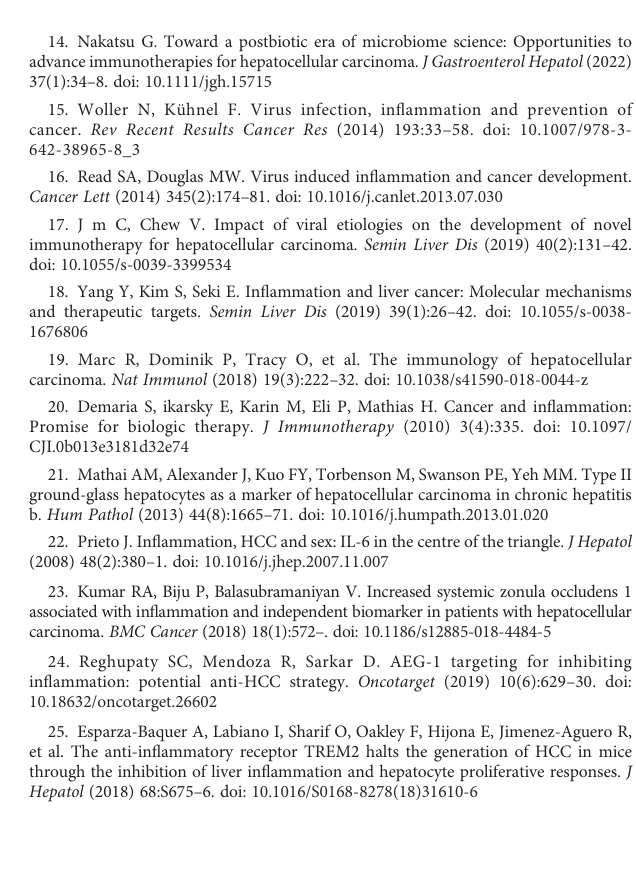
SUPPLEMENTARY FIGURE 1 Validation of prognostic models for six in fl ammation-related signatures. (A – C) risk score distribution, survival status, the expression level of hub genes, Principal component analysis, and Kaplan-Meier curves at different risk groups from ICGA database (A) and GSE84337 database (B) . *p < 0.05. SUPPLEMENTARY FIGURE 2 The correlation analysis of IRG and clinicopathological variables and corresponding strati fi cation analysis in virus-related HCCs. The correlation between IRG and (A) Age, (B) Alcohol consumption, (C) Gender, (D) TNM stage, (E) Fetoprotein, and (F) Radiation therapy and its corresponding OS analysis. *p < 0.05, **p < 0.01, ***p < 0.001. SUPPLEMENTARY FIGURE 3 Correlations between IRG and immune cell